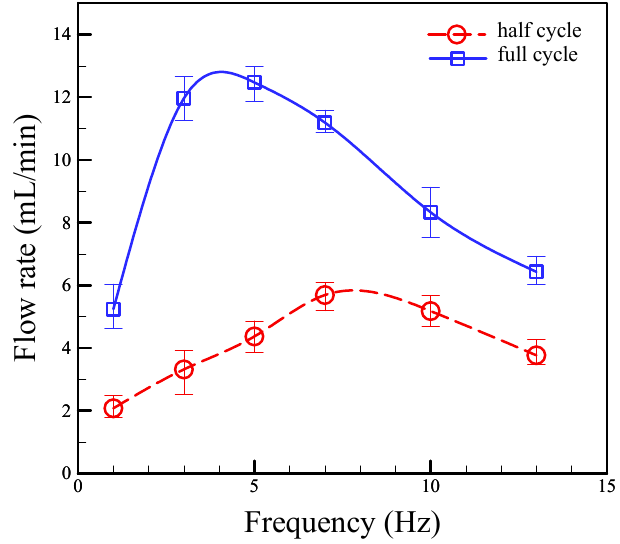
Figure 11. Relationship between flow rate and operating frequency at different operation modes of half cycle and full cycle strokes. Error bars were evaluated by three samples and six tests.